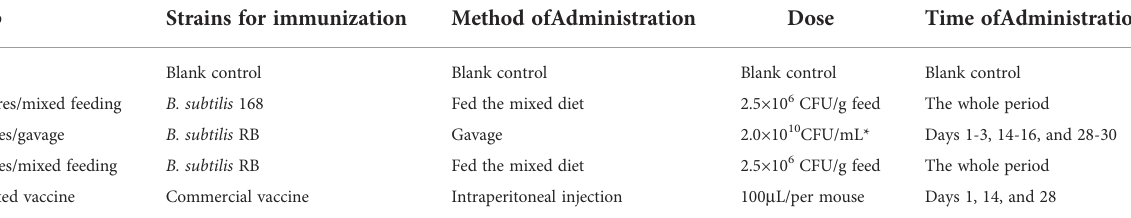
TABLE 1 Program for the vaccination experiment.